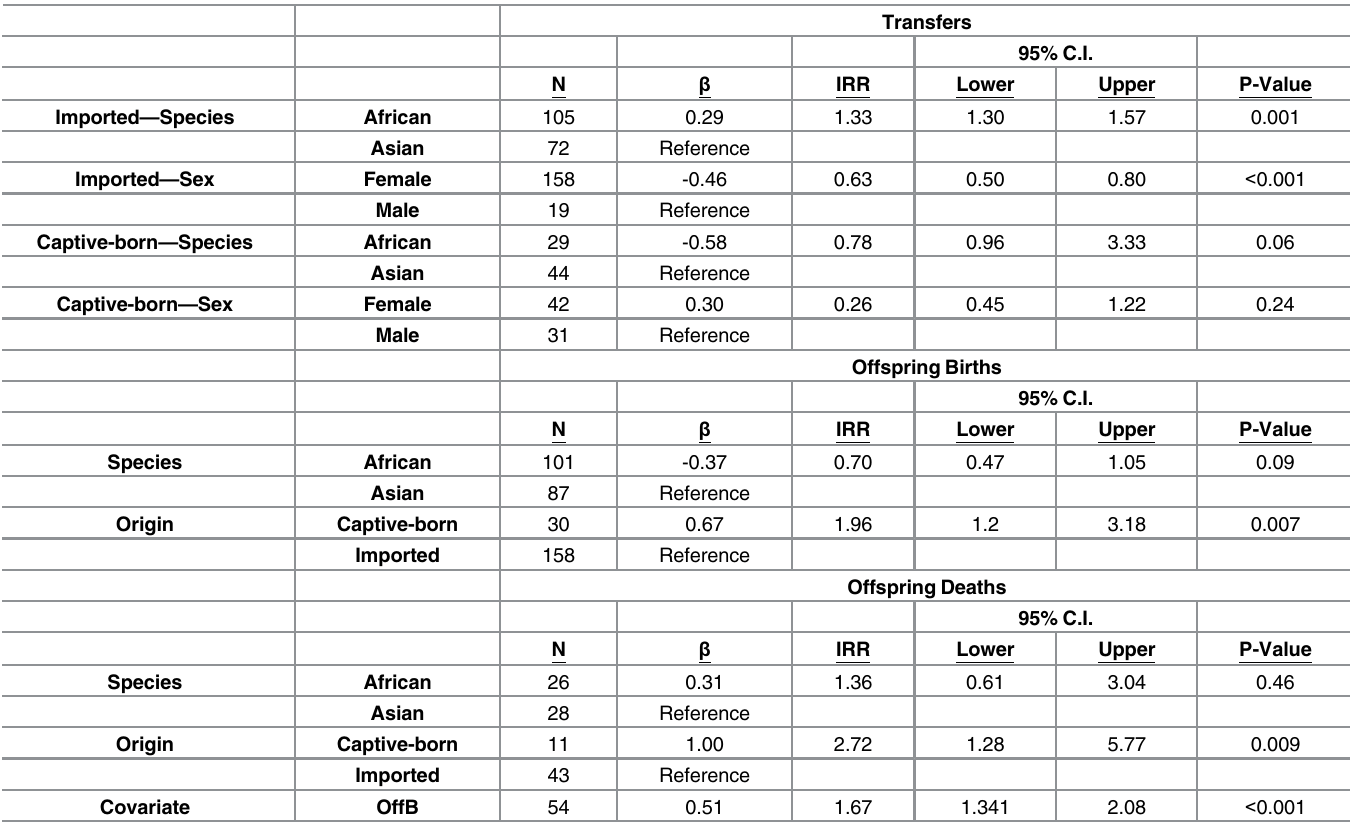
Table 5. Summary of parameter estimates from Poisson regression models, including beta estimates, standard errors (SE) and corresponding 95% confidence intervals. p <